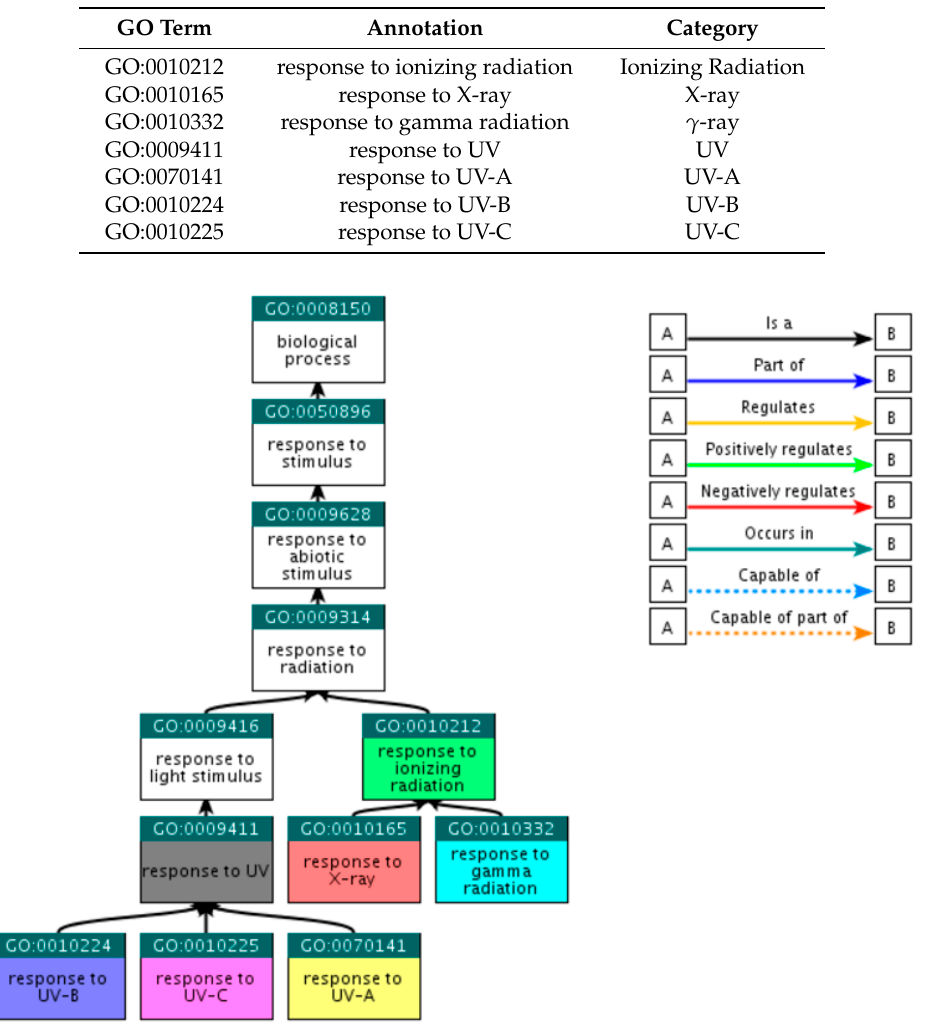
Figure 1. Ancestor tree showing the hierarchical relations of the seven selected GO terms. The 48 rest child terms, referred in the text, are not presented.